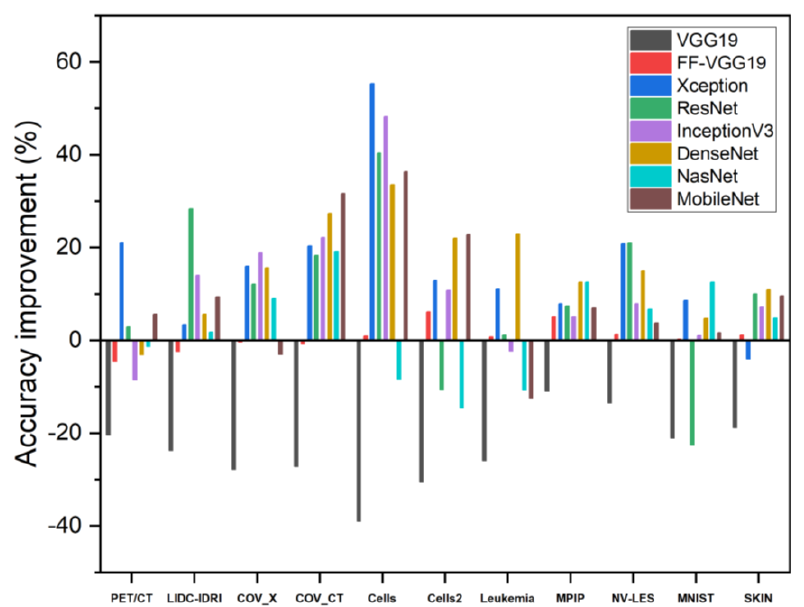
Figure 3. Accuracy improvement of the CNNs when training from scratch on the study ’ s